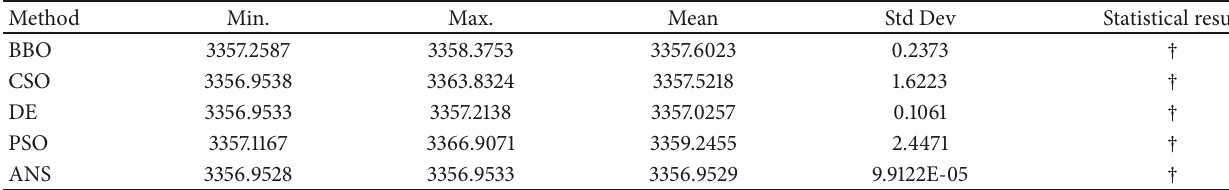
Table 11: Comparison of simulation results (t/h).